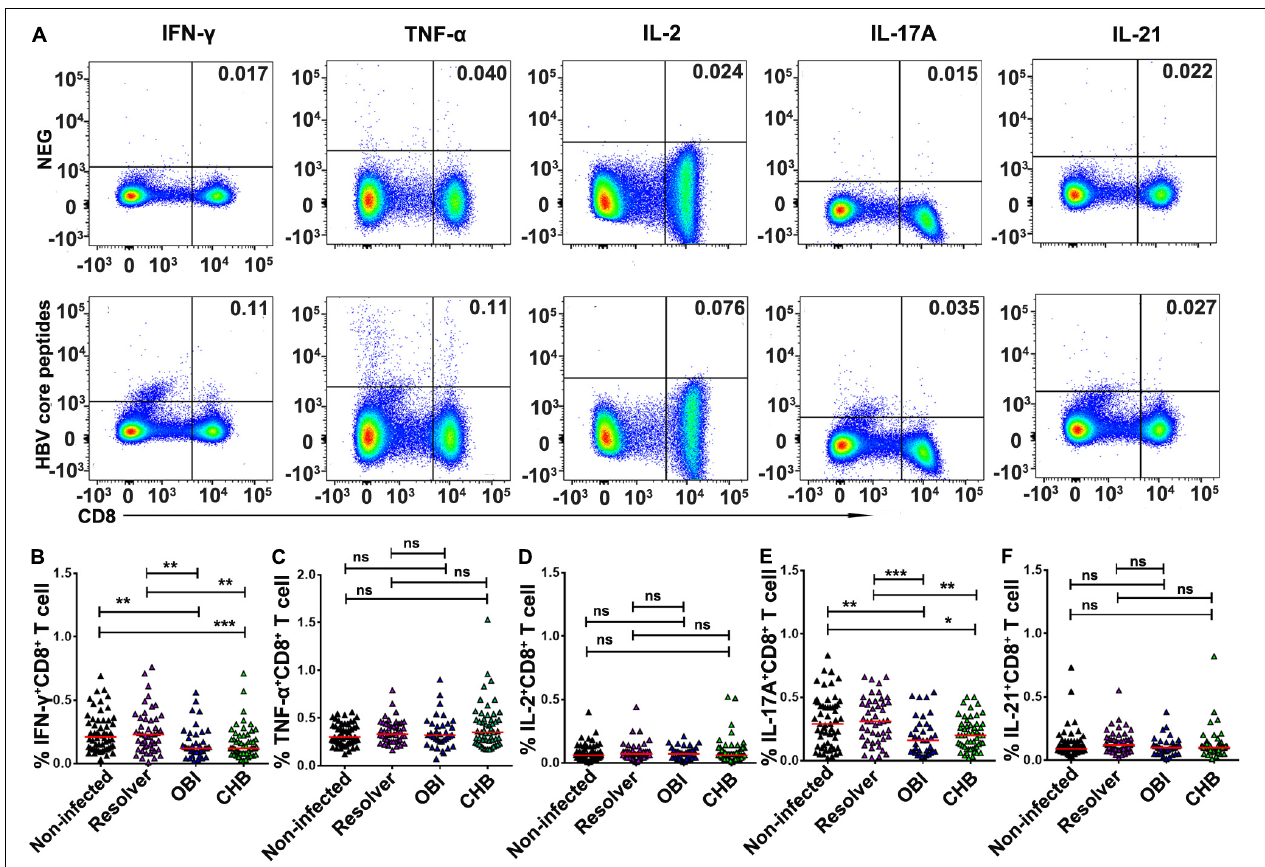
FIGURE 4 | Frequency of intracellular cytokine expressing CD8 + T cells after stimulation of HBV core peptides. PBMCs were freshly isolated from individual blood donors and tested by ICS for intracellular IFN- γ , TNF- α , IL-2, IL-17A, or IL-21 secreting CD8 + T-cell response, respectively, after simulation with core peptides for 6 h. (A) Representative flow-cytometric analysis of reactivity of CD8 + T cells from an OBI donor stimulated with negative control and HBV core peptides. (B–F) The frequency of intracellular cytokine secreting CD8 + T-cell response was expressed as a mean of triplicates for each individual donor. A median of frequency in each group is indicated and the differences between groups are compared with the Mann–Whitney test. Statistically significant differences are shown with asterisks (* P < 0.05, ** P < 0.01, and *** P < 0.001); ns, no significant difference.